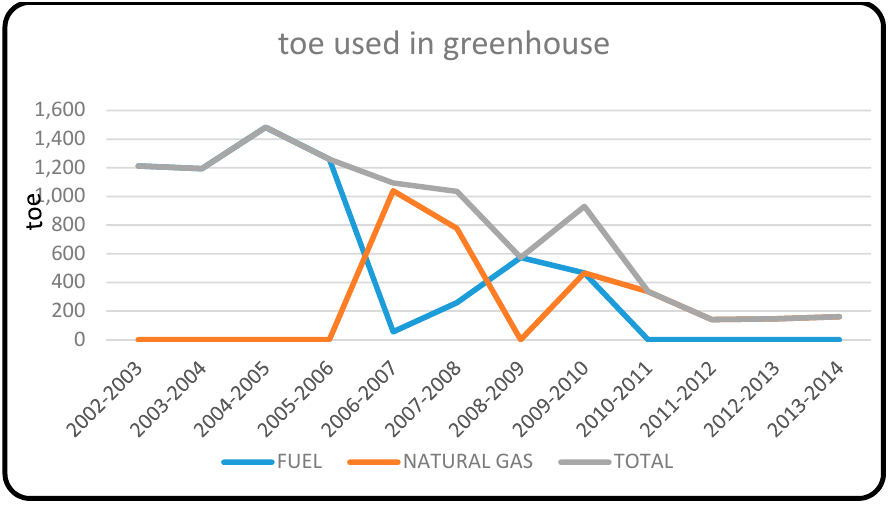
Figure 10. Toe by type of fuel. Source: Fieldwork